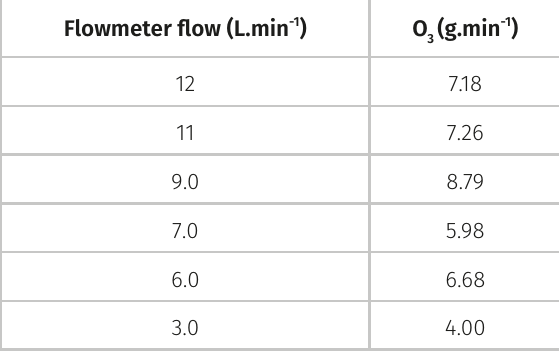
production generated 3